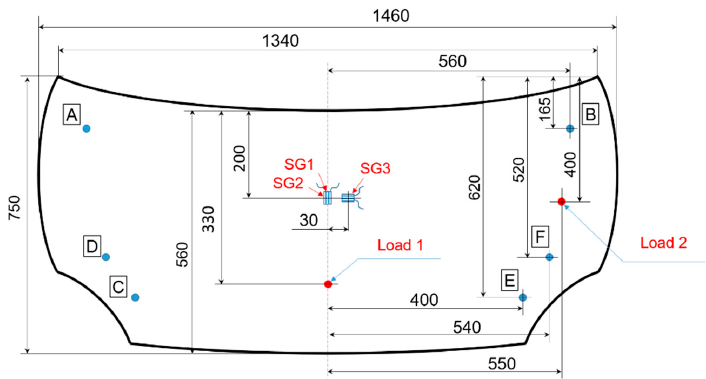
Figure 13. Supports and application points of the loads for investigated composite hoods.